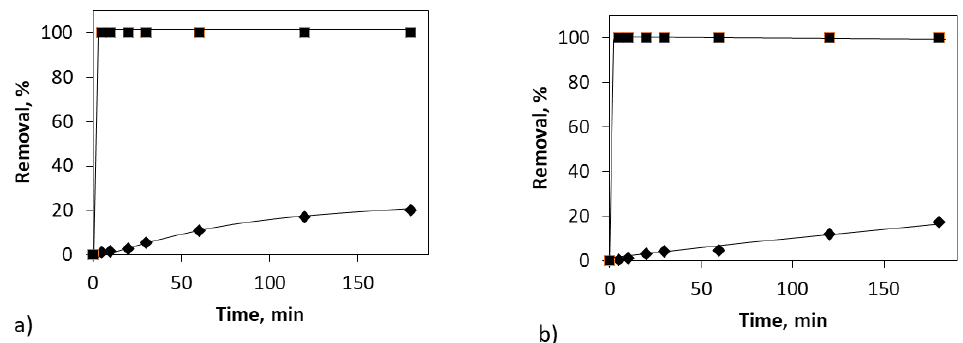
Figure 2. Influence of the water matrix on the pollutant removal by direct photolysis. ( a ) DW; ( b ) SW. ♦ — caffeine; ■ — insecticides mix.